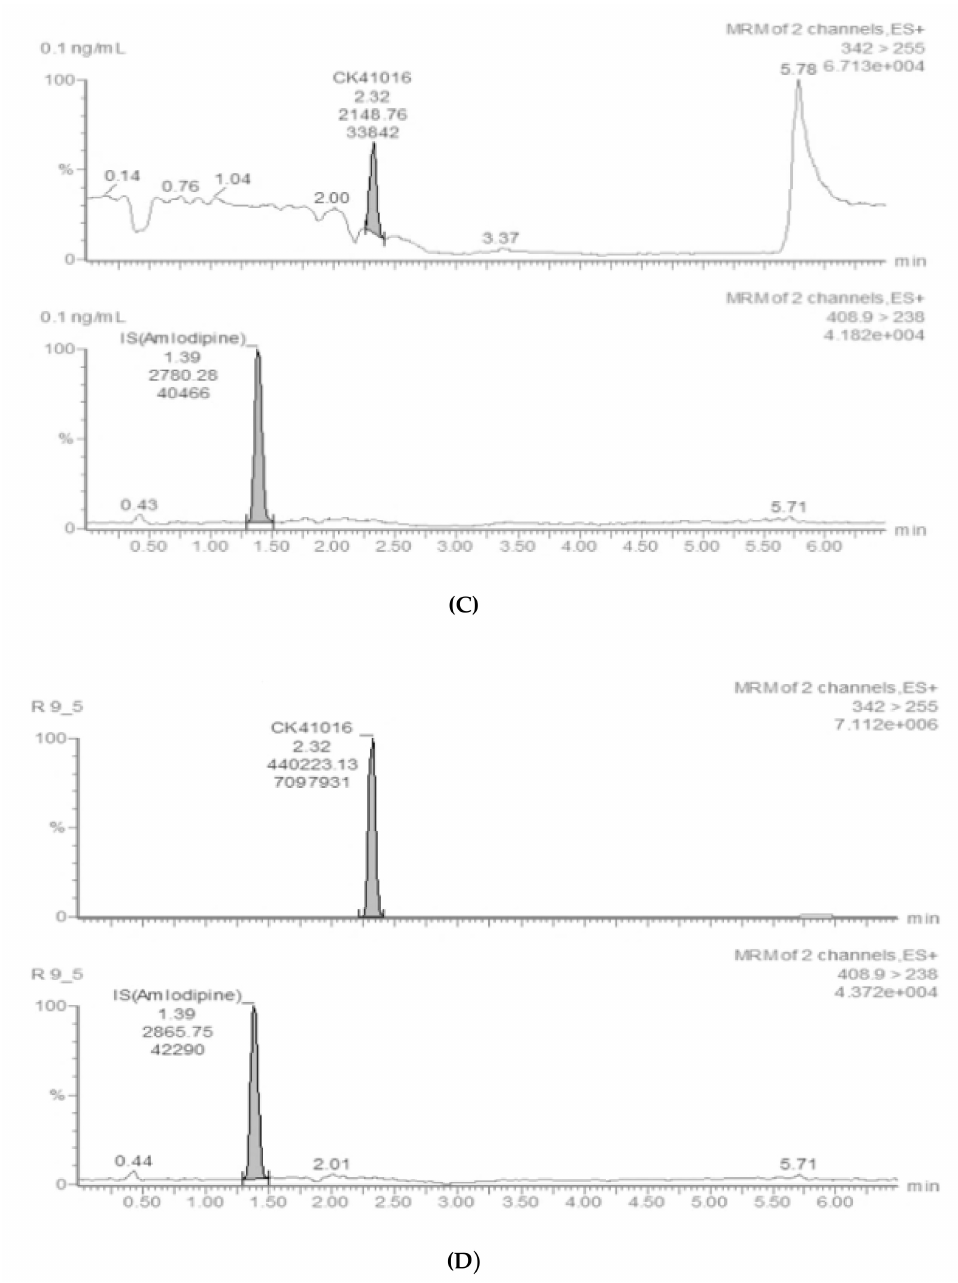
Figure 2. Representative multiple reaction monitoring (MRM) chromatograms of CK41016 in rat plasma. Blank rat plasma ( A ), zero-blank rat plasma spiked with IS (20 ng / mL) in extracted blank plasma ( B ), standard solution of CK41016 (0.1 ng / mL) and IS ( C ), and rat plasma taken at 5 min after eye drop administration of 75.21 µ g / kg CK41016 ( D